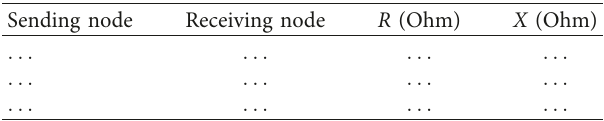
Table 2: Line data